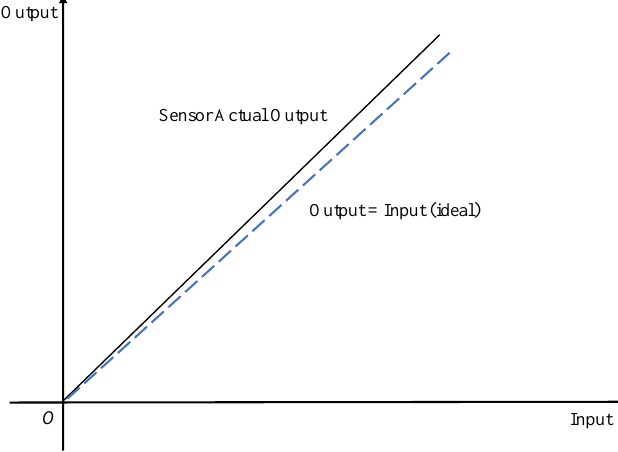
Figure 4. Scale factor error schematic.